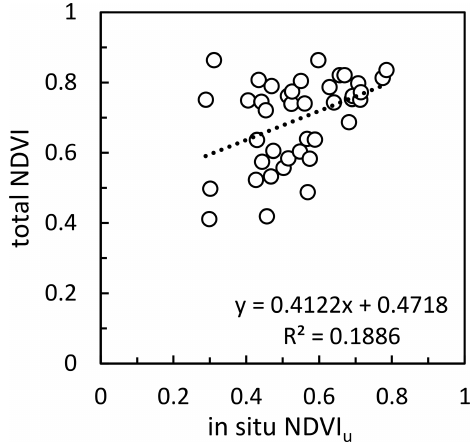
Figure 4. Relationship between total (overstory and understory) NDVI values computed from nadir NDVI values, using MODIS BRDF/albedo data and in situ measured understory NDVI values over the study